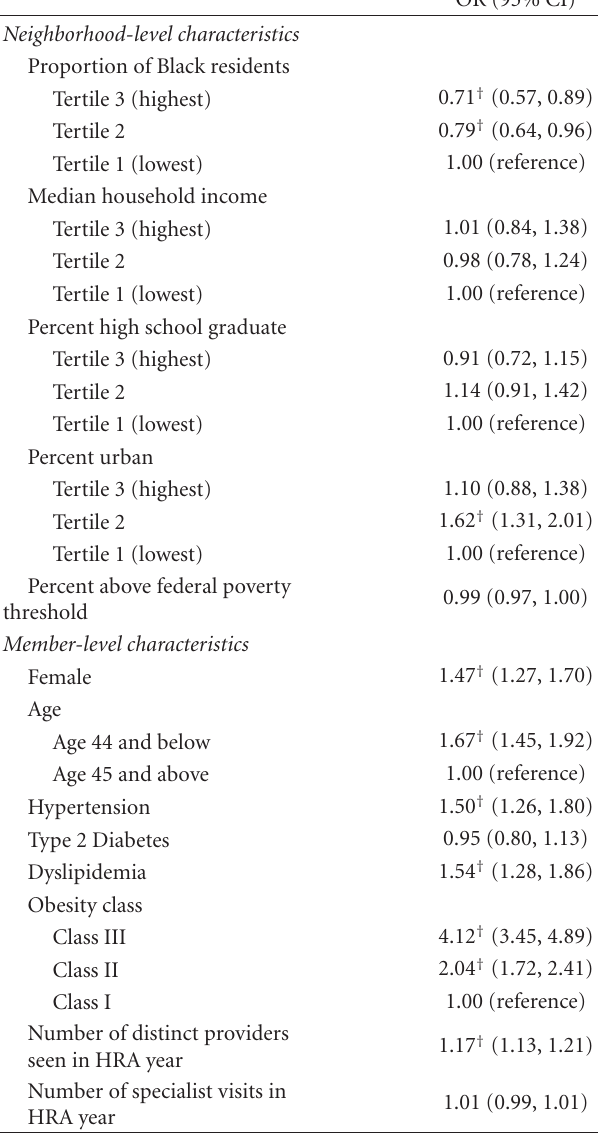
Table 2: Adjusted association of neighborhood characteristics and obesity claim among insured population ( N = 13,434).